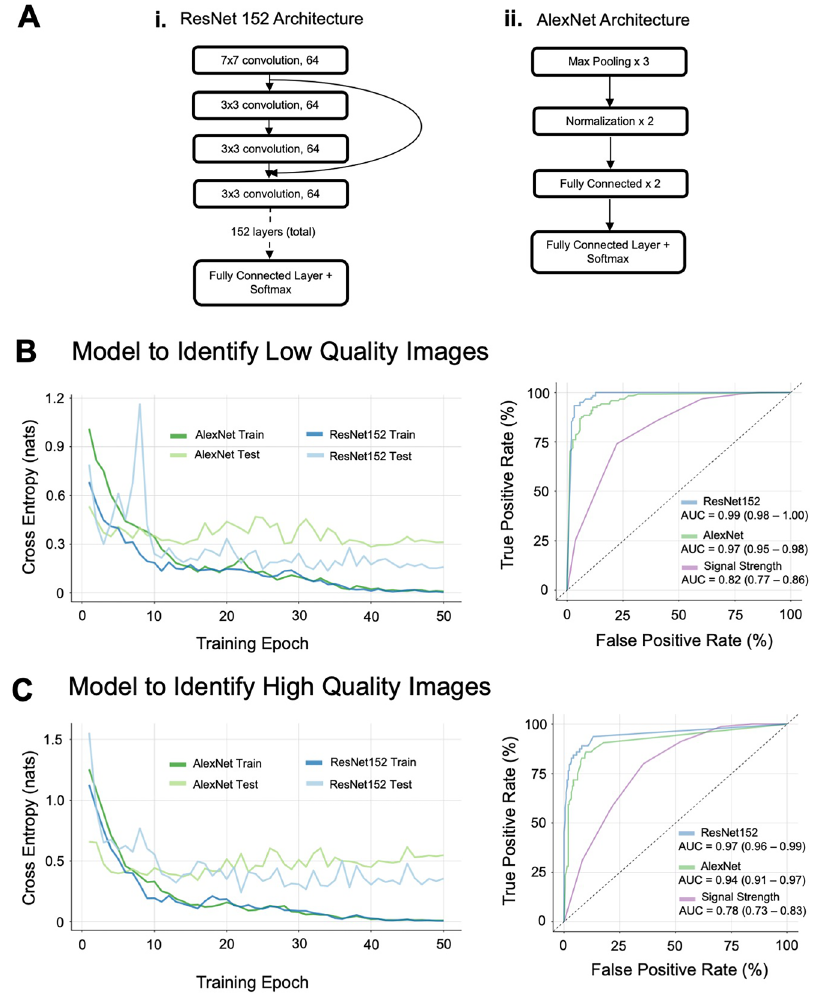
Figure 3. ResNet transfer learning achieves significant improvements in identification of image quality in both low quality and high quality use cases over machine-reported signal strength. ( A ) Simplified architecture diagrams for the pretrained (i) ResNet152 and (ii) AlexNet architectures employed. ( B ) Training history and receiver operating characteristic curves for ResNet152 versus machine-reported signal strength and AlexNet for low quality criteria. ( C ) Training history and receiver operating characteristic curves for ResNet152 versus machine-reported signal strength and AlexNet for high quality criteria.